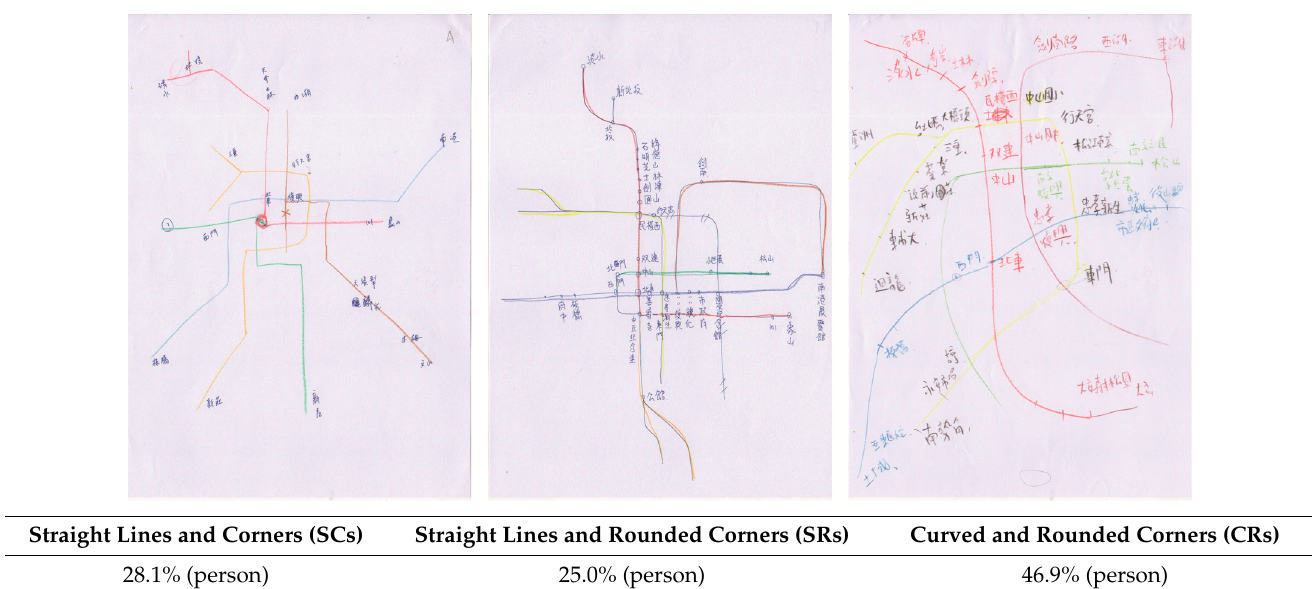
Table 2. Percentage of participants using each composition type in cognitive mapping.